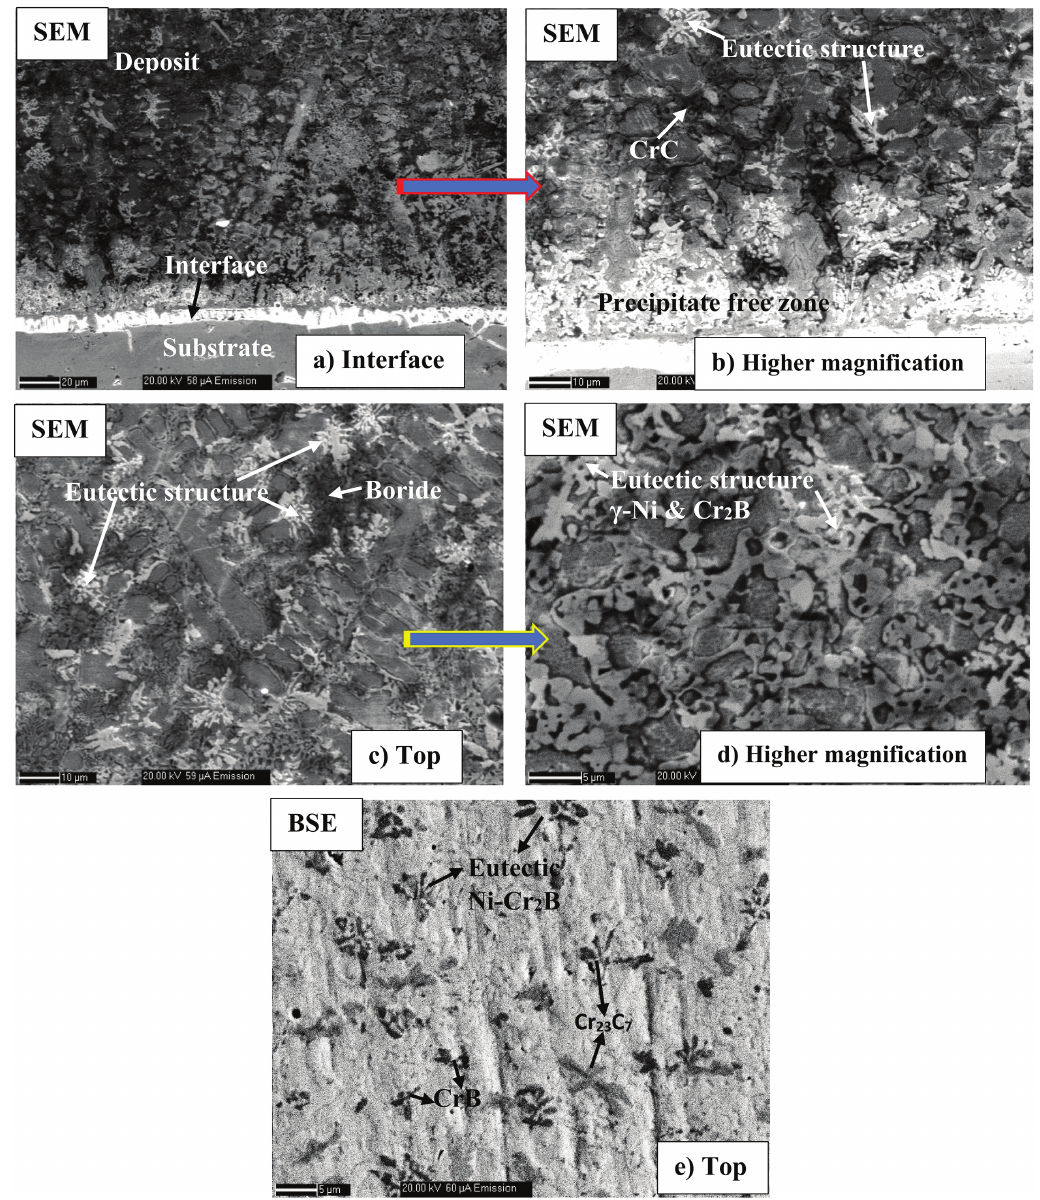
Figure 7: Scanning electron micrograph for various